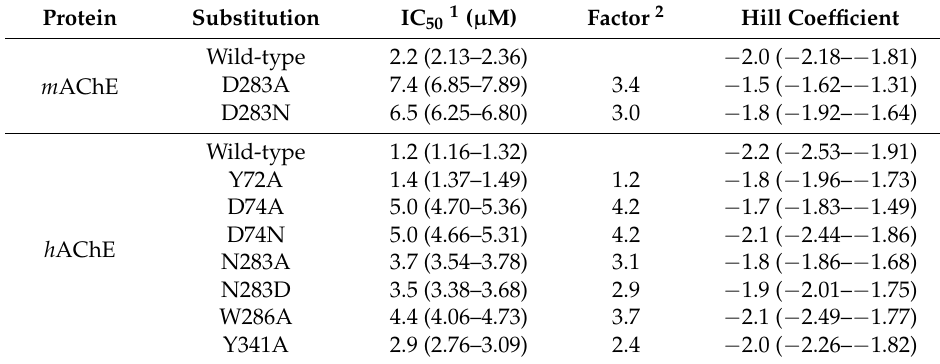
Table 2. The IC 50 and Hill coefficient for site directed mutants.